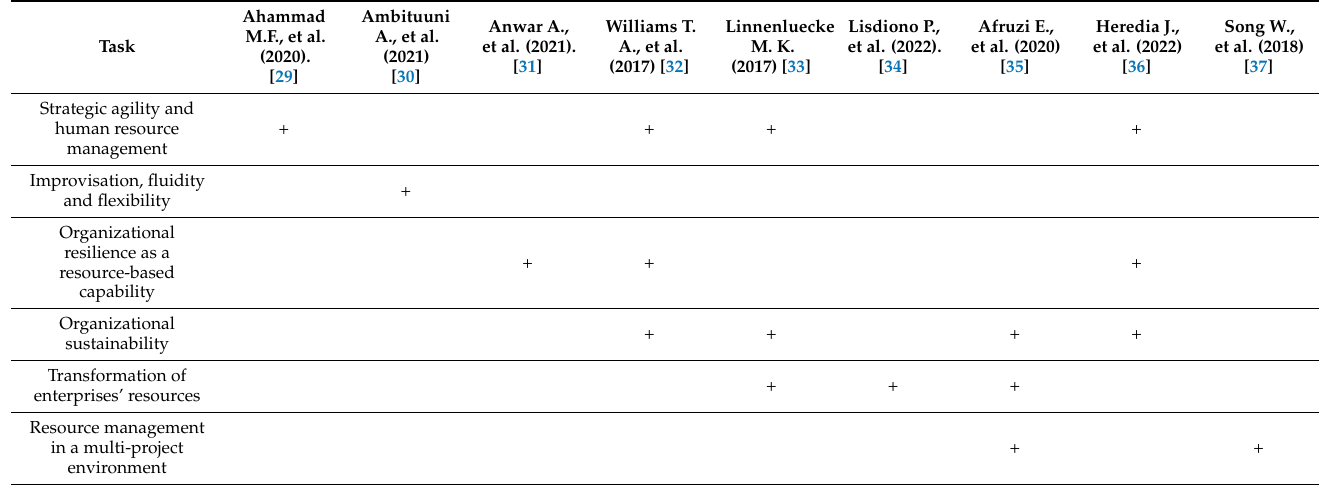
Table 1. Analysis of models for ensuring adaptability and resilience of project